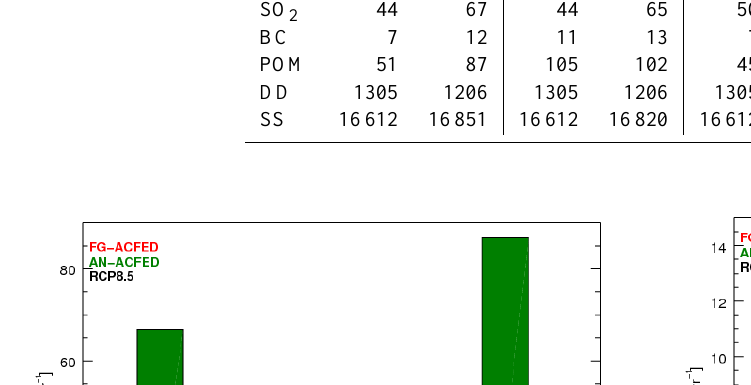
Fig. 3. Global-yearly emissions of SO 2 (in TgSyr − 1 ), BC and POM (in Tgyr − 1 ) of first guess (FG, red), analysis (AN, green) and projected RCP8.5 emissions for the year 2010 (RCP, black). The FG combines the anthropogenic emissions from L10 and the GFED biomass burning emissions.